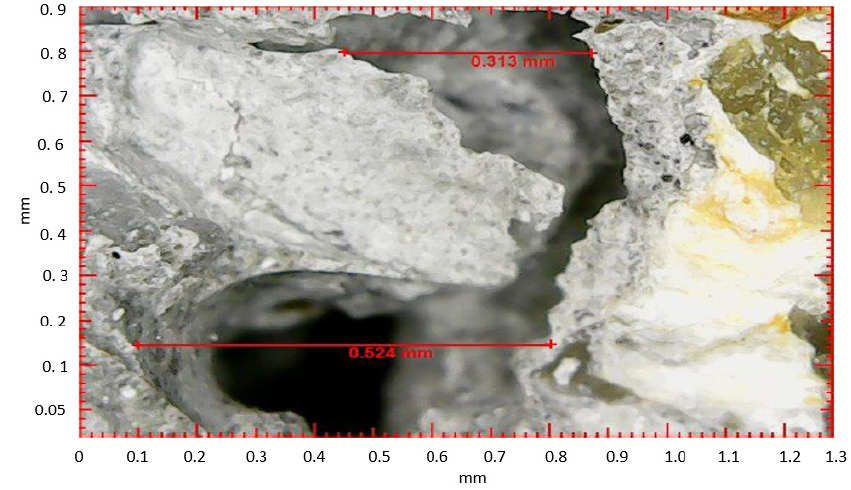
Figure 4. Structures of the air void system of PC.